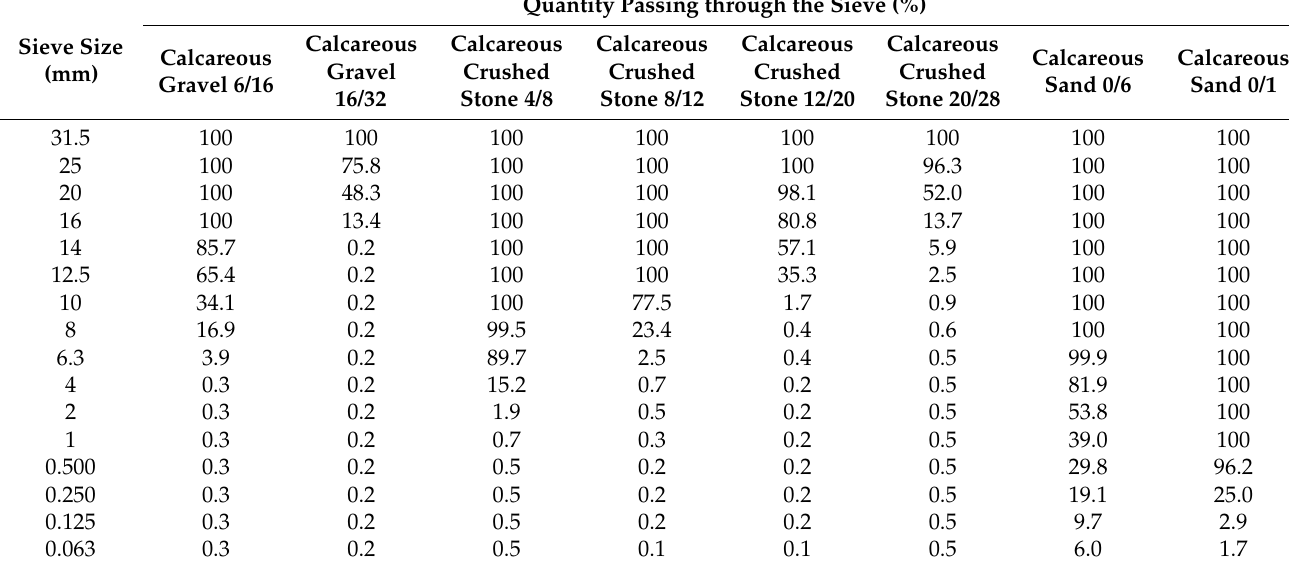
Table 6. Particle size dimension of calcareous gravel, calcareous crushed stone, calcareous sand and sand samples analyzed, expressed in percentage for each sieve selected and expressed in mm.